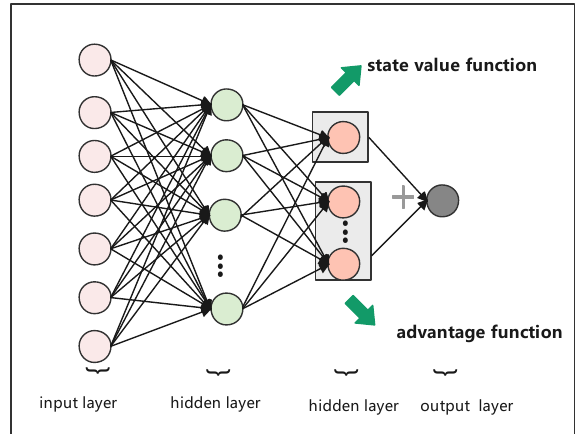
Figure 2. The neural network structure based on a dueling